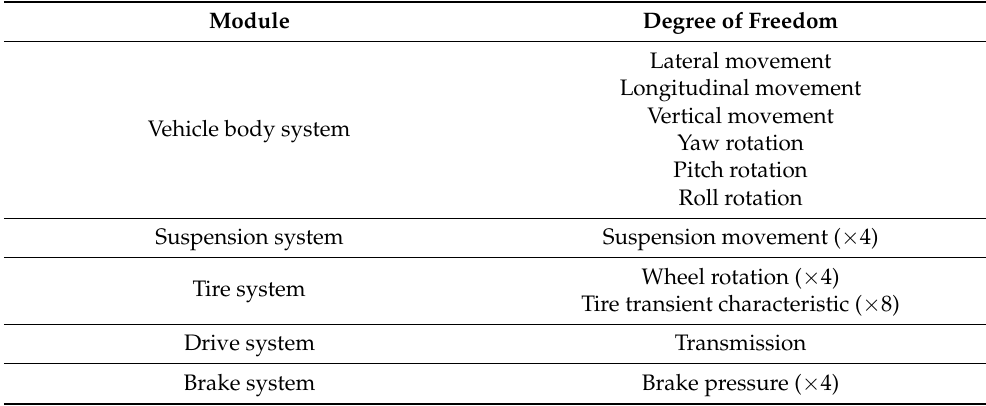
Table 1. Degrees of freedom for each